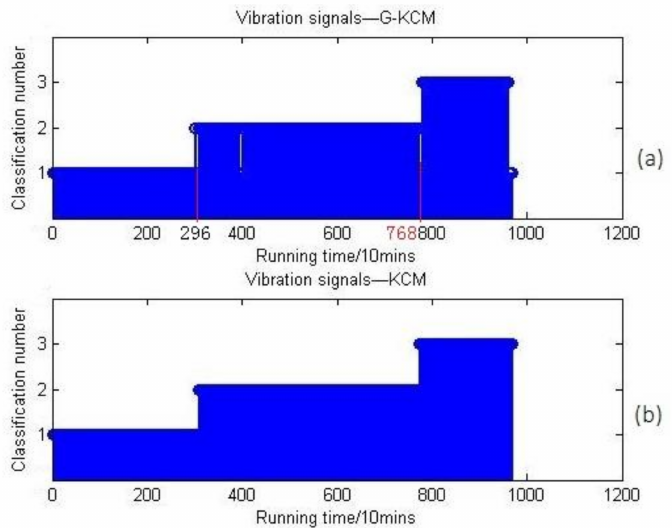
Figure 18. ( a ) Vibration signals clustering results based on G-KCM; ( b ) vibration signals clustering results based on